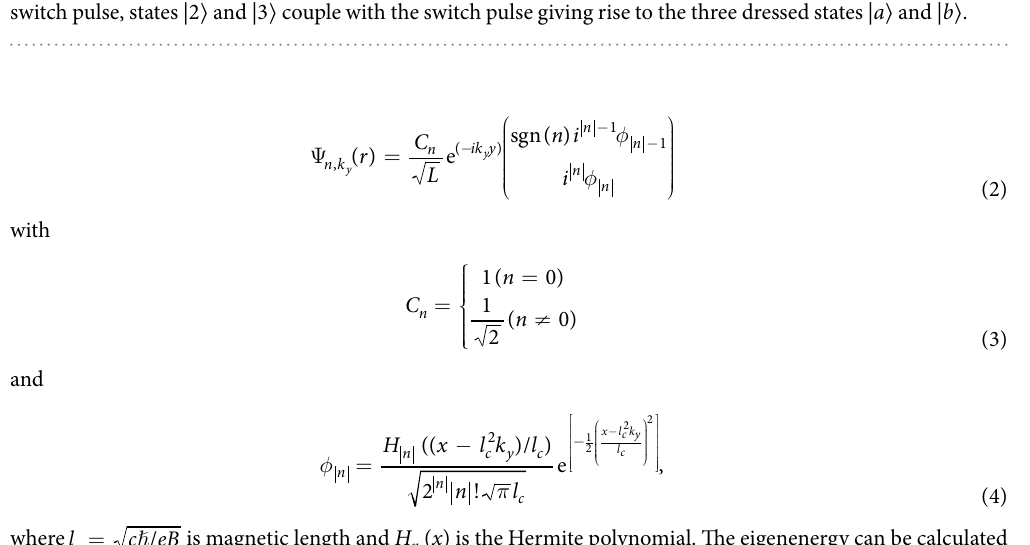
Figure 2. ( a ) Landau levels (LLs) near the Dirac point superimposed on the linear electron dispersion without the magnetic field υ = ± E p . The magnetic field condenses the original states in the Dirac cone into discrete F energies. ( b ) Energy level diagram and optical transitions in graphene interacting with a weak probe pulse (with carrier frequency ω p ) and a THz switch pulse (with carrier frequency ω TH ). The states are labeled as |1 〉 , |2 〉 and |3 〉 corresponding to the LLs with energy quantum numbers n = − 1, 1, 2, respectively. The monolayer graphene is regarded as a perfect two-dimensional (2D) crystal structure in the x − y plane. Inset : in the presence of the switch pulse, states |2 〉 and |3 〉 couple with the switch pulse giving rise to the three dressed states | a 〉 and | b 〉